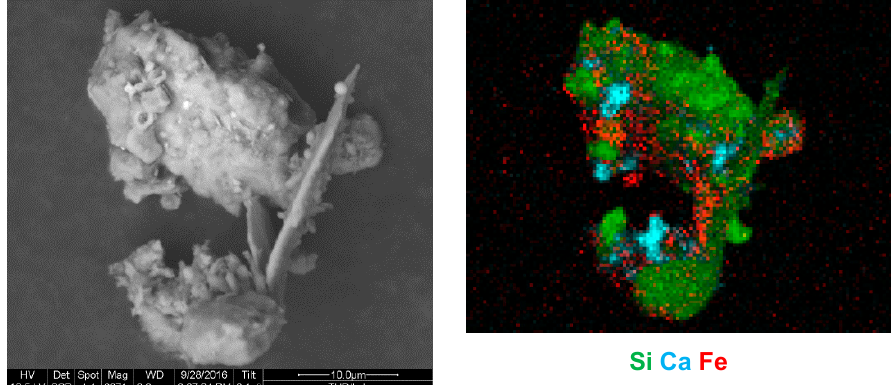
Figure 6. Mixing state of iron (black circles) and calcium (colored circles) as functions of Ca and Fe indices for near-source ( a , e , f ) and transported ( b – d ) dust dry deposition. The circle area is proportional to total iron or calcium mass found in each class, normalized to the highest mass for each sampling location. The blue-red transition shows the average relative ion balance of Ca 2+ + Mg 2+ versus SO4 2 − , indicating atmospheric processing.